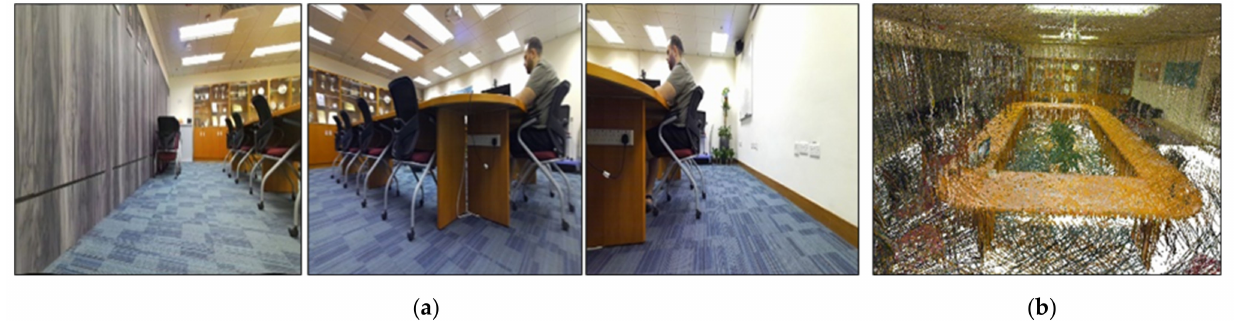
Figure 6. Moderate-texture setup. ( a ) The three left frames show the surveying environment contain- ing some low-texture walls. ( b ) Ground truth model using the Leica BLK360 imaging laser